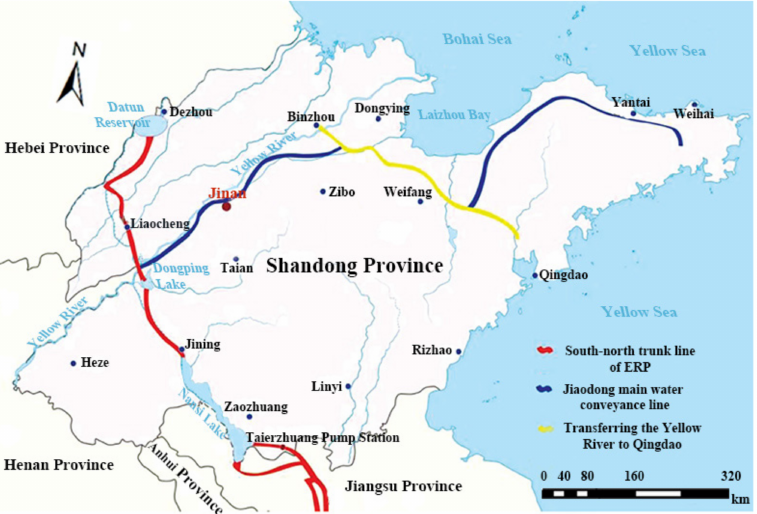
Figure 1. Map of the East Route of the South-to-North Water Diversion Project (ERP).